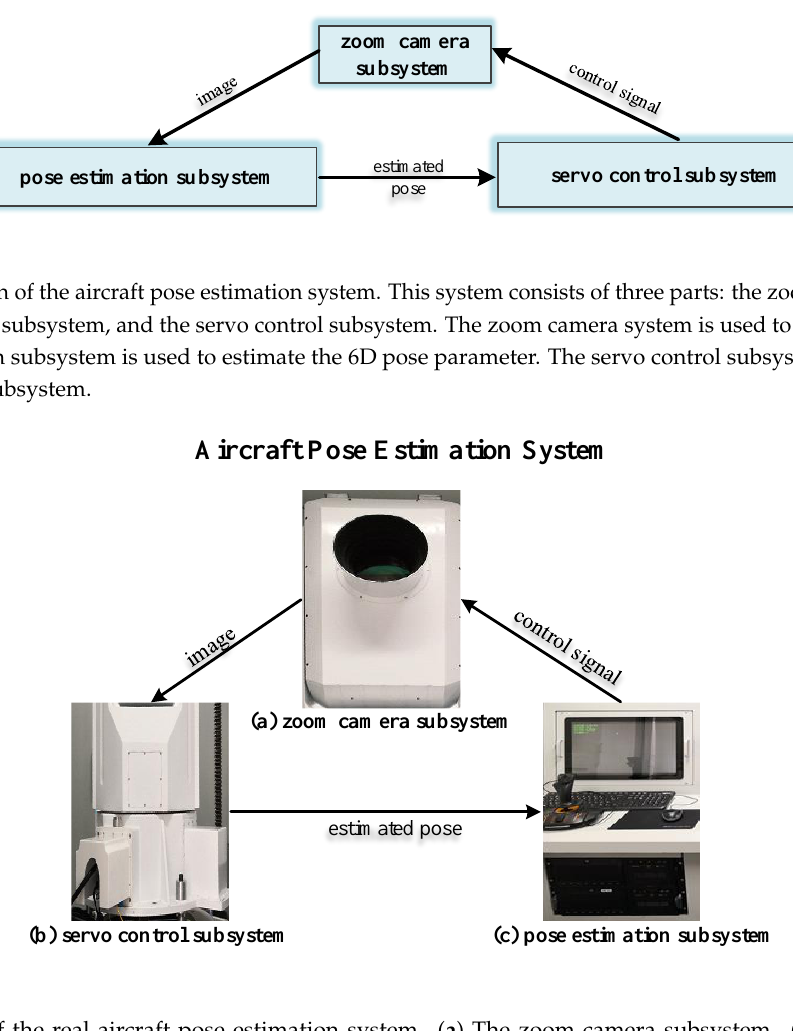
Figure 2. Figure of the real aircraft pose estimation system. ( a ) The zoom camera subsystem. ( b ) The servo control subsystem. ( c ) The pose estimation